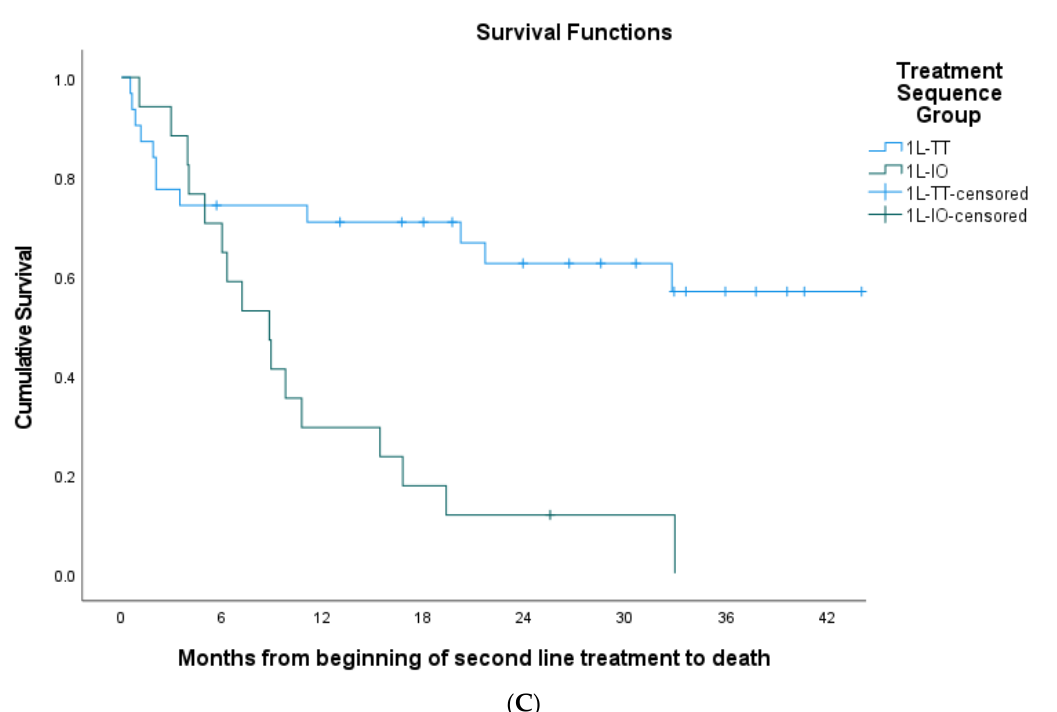
Figure 2. Sensitivity analyses survival outcomes excluding BRAF V600D and unknown subtypes ( n = 89). ( A ) Overall survival of 1L-IO vs. 1L-TT Group in BRAF V600E/K-mutant population only (16.3 vs. 19.3 months, p = 0.230); ( B ) overall survival of ‘1L-IO only’ vs. ‘1L-TT to 2L-IO’ vs. ‘1L-IO to 2L-TT’ vs. ‘1L-TT only’ in BRAF V600E/K-mutant population only (NR vs. NR vs. 16.3 vs. 8.4 months, p < 0.001); ( C ) survival from second-line treatment to time of death/last follow up as per 1L-IO vs. 1L-TT group only’ in BRAF V600E/K-mutant population only (8.8 vs. NR, p < 0.001).